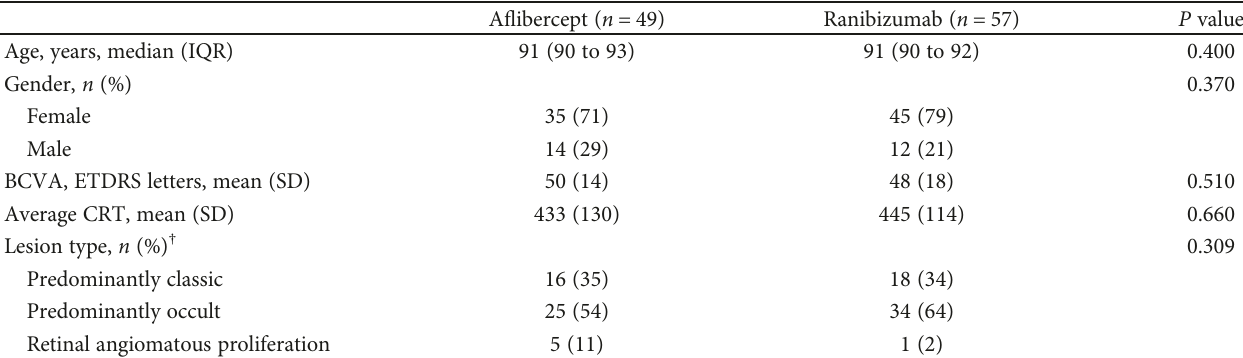
Figure 1: Treatmentadherenceinrelationtodi ff erentreasonsfordiscontinuationshownintime-to-eventcurves.ComparingA fl ibercept(red) withRanibizumab(blue)didnotshowanystatisticallysigni fi cantdi ff erences.(a)Deathwasanissuethroughouttheentirefollow-upperiod.(b) Patientsfeelingburdenedbythetreatmentoptedoutmostlywithinthe fi rstyear.(c)TreatmentdiscontinuationduetoinactiveCNV/drymacula was only seen after the fi rst year. (d) Treatment discontinuation due to a fi brotic/untreatable lesion was mostly within the fi rst Table 2: Baseline factors of patients with neovascular age-related macular degeneration aged ≥ 90 years enrolled in A fl ibercept or Ranibizumab treatment, which remained in treatment for at least the follow-up after the loading dose phase.